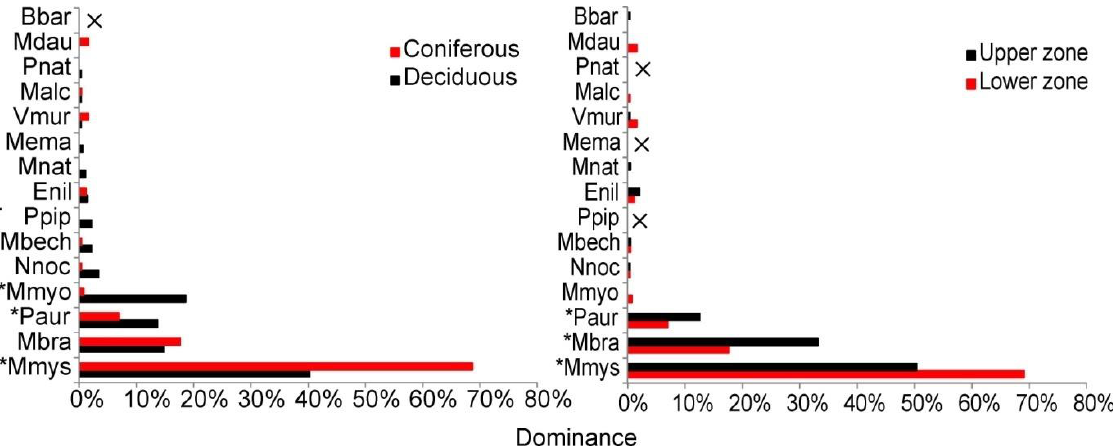
Figure 9. Dominance structure of bat assemblages recorded in the deciduous and coniferous forests of the upper and lower zone in the Polish Tatra Mountains, 2016 – 2020. Used symbols: *frequency of species significantly differed between forests p ≤ 0.05, X— lack of species. For species abbreviations see description of Figure 2.